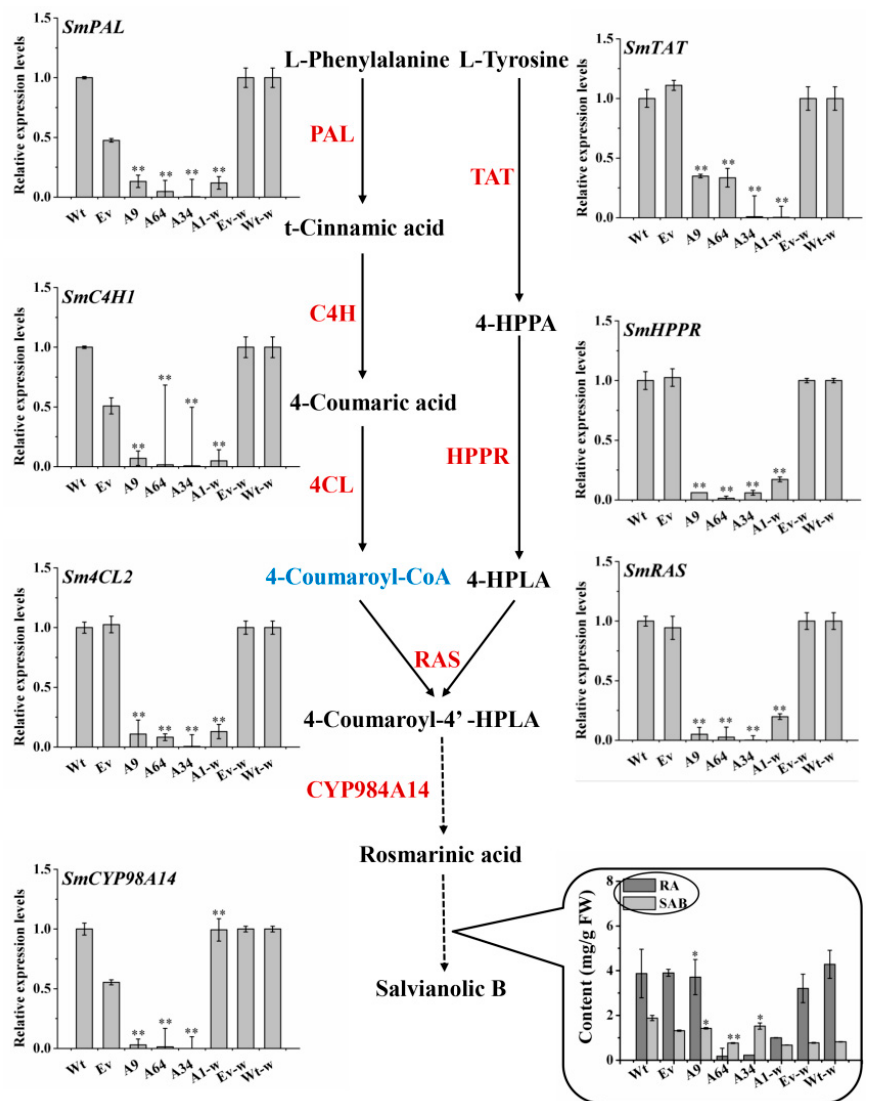
Figure 7. The contents of phenolic acids and expression pattern of the structure genes involved in salvianolic acid biosynthesis in transgenic lines. Solid arrows and dashed arrows represent single-step reactions and multiple steps reactions, respectively. Wt, the controls that were untransformed wild S. miltiorrhiza plants. Ev, the controls that only transformed the empty vector in S. miltiorrhiza . A9, A64, and A34, three transgenic lines of SmANS -overexpressed in S. miltiorrhiza . A1-w, transgenic line of SmANS -overexpressing in S. miltiorrhiza Bge f. alba . Ev-w, the controls that only transformed the empty vector in S. miltiorrhiza Bge f. alba . Wt-w, the controls that were untransformed wild S. miltiorrhiza Bge f. alba plants. The vertical bars show the SD values from three independent biological replicates. (*) indicated a significant difference (0.01 < p < 0.05). (**) indicated a very significant difference ( p < 0.01).